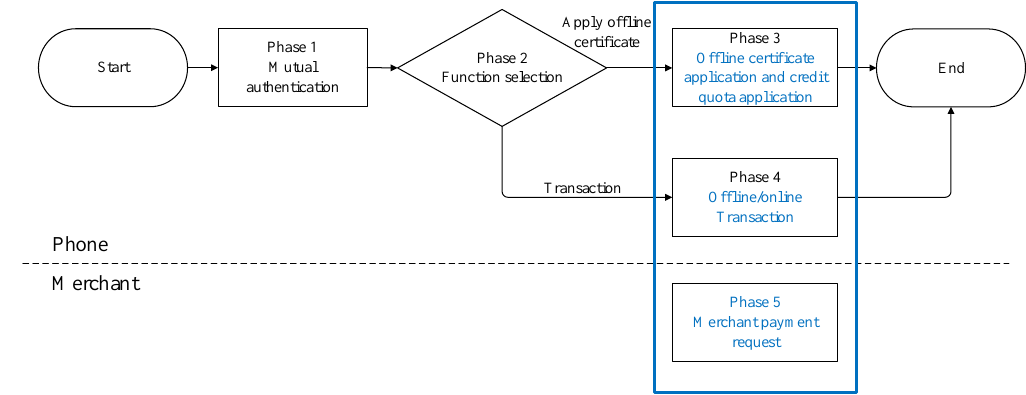
Figure 2. EOPMA flowchart.